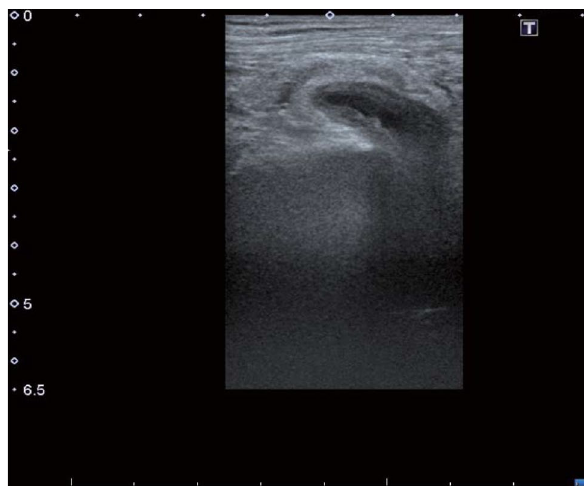
Figure 2. Ultrasound showed the incarcerated small